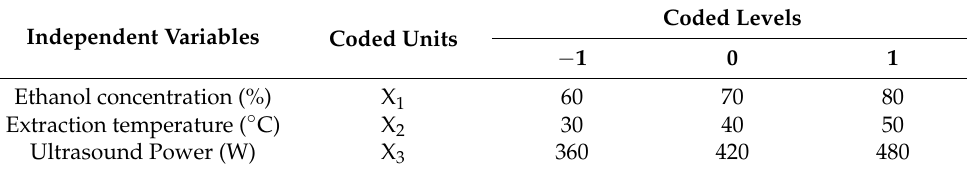
Table 1. Coded levels of the independent variables.